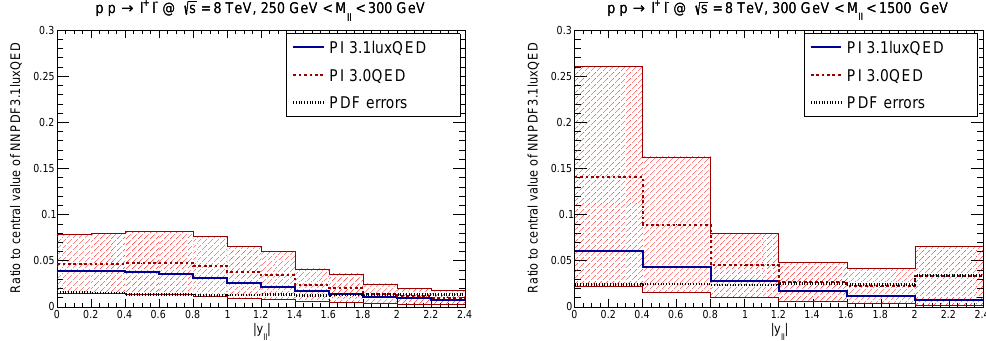
Figure 4.4: Same as Fig. 4.3 for the kinematics of the ATLAS high-mass DY measurement at 8 TeV. We show results for the lepton-pair rapidity distributions | y ≤ 300 GeV (upper) and 300 GeV ≤ M mass bins, 250 GeV ≤ M ll